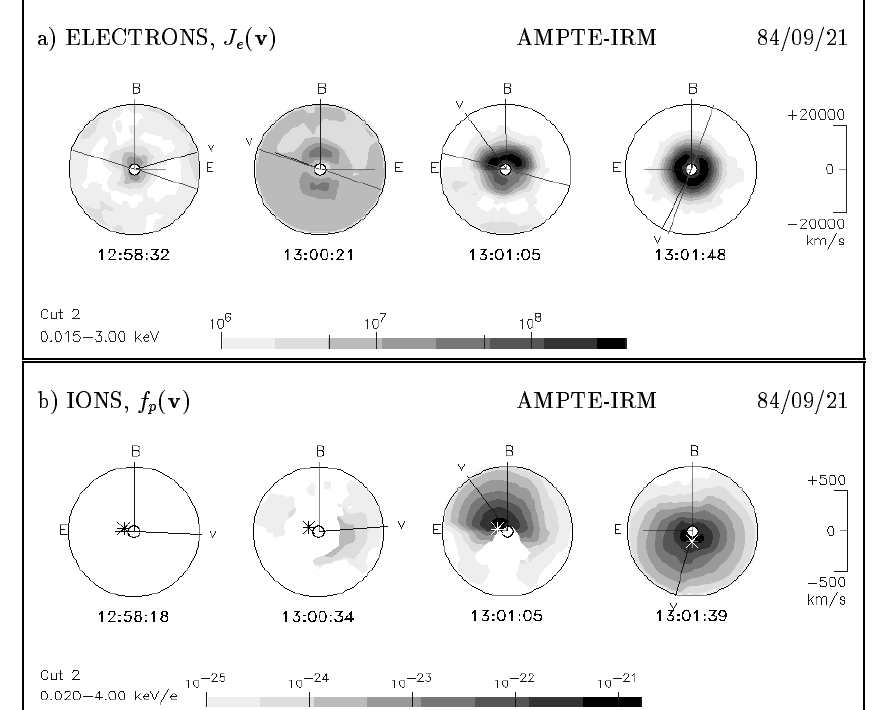
Fig. 2. Ion distributions in the energy range of 20eV–4keV and electron distributions in the range of 15eV–3keV measured on 21 September 1984. Panel a shows the differential directional energy flux density J e (in eV / s cm 2 eV sr ) of electrons. Panel b shows the phase space density f p (in cm − 6 s 3 ) of ions. The distributions are shown in a two-dimensional cut through velocity space in the spacecraft frame that contains the magnetic field direction, B (upward), and n × B (to the left), where n is the magnetopause normal. Moreover, projections of the directions of the proton bulk flow, V p , and the convection electric field, E c = − V p × B , are given. Black or white stars in the ion distributions give the projection of the de Hoffmann-Teller velocity, V HT , onto the cut. V HT is determined by the minimization of D (Eq. 1) and is the origin of the v 0 system used in the text. In the electron distributions there is another line which is symmetric about v = 0 . This line gives the projection of the IRM spin axis. Due to an instrumental defect, some distributions exhibit a reduced electron flux along the spin axis at low energies.